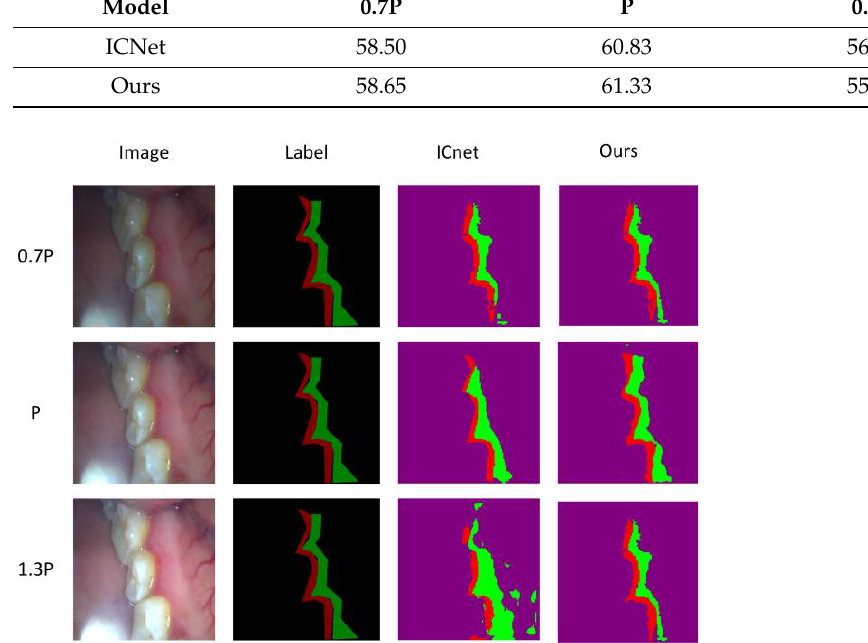
Figure 14. Visualization comparison of segmentation results under different brightness.